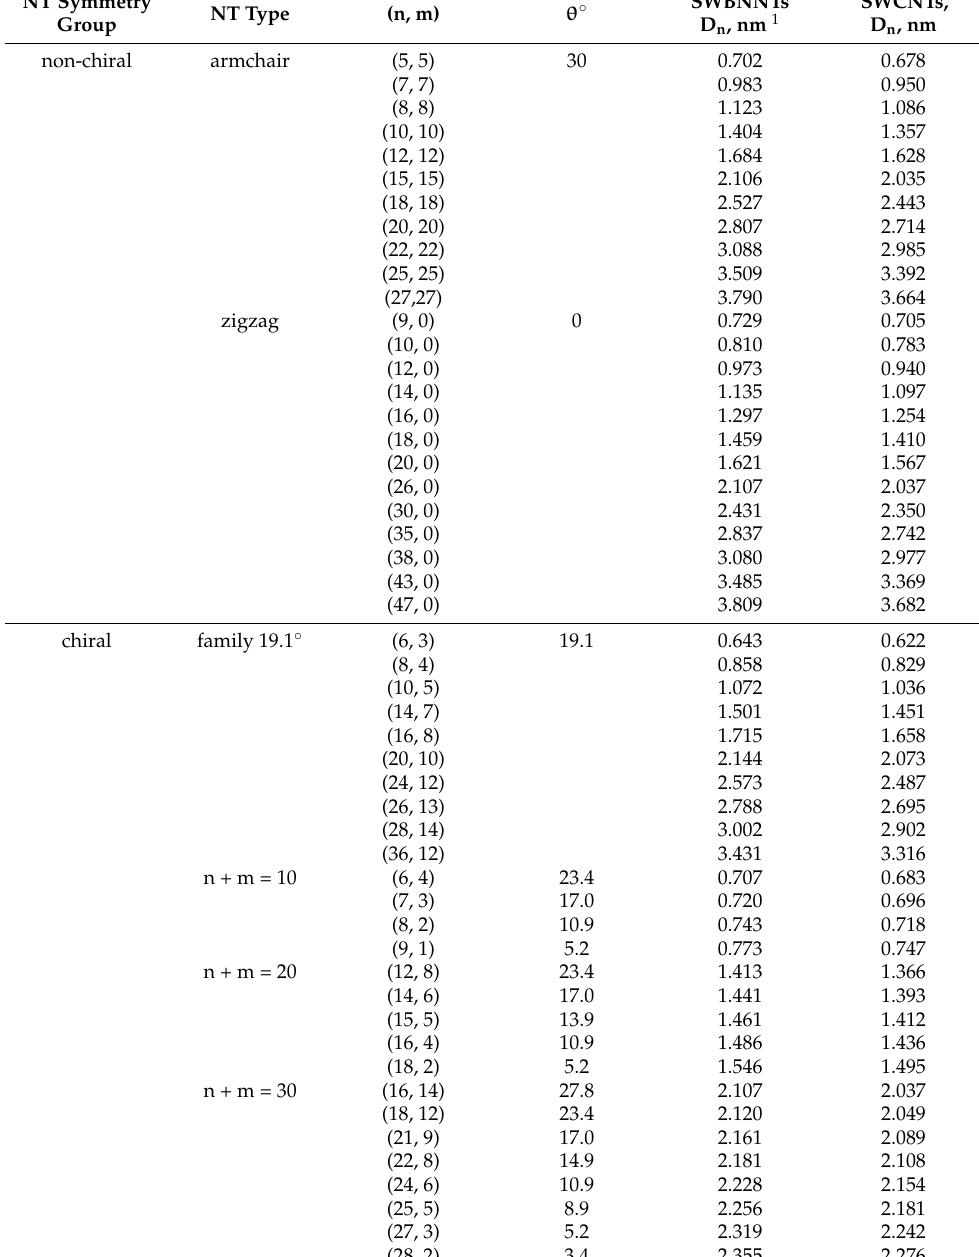
Table 4. Geometrical characteristics of the studied SWBNNTs and